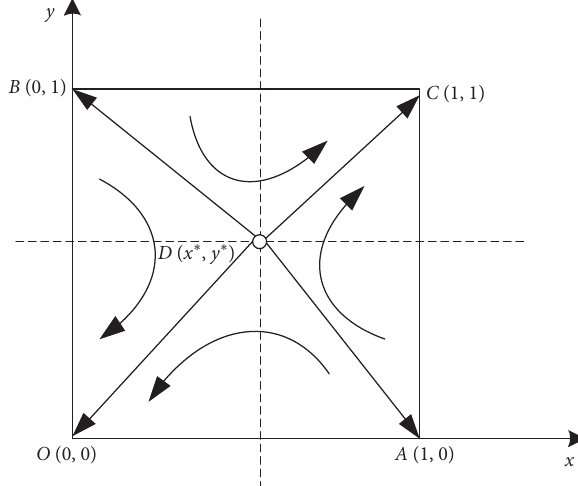
− β l ) / (( 1 − α ) C − λ l )) 1 1 1